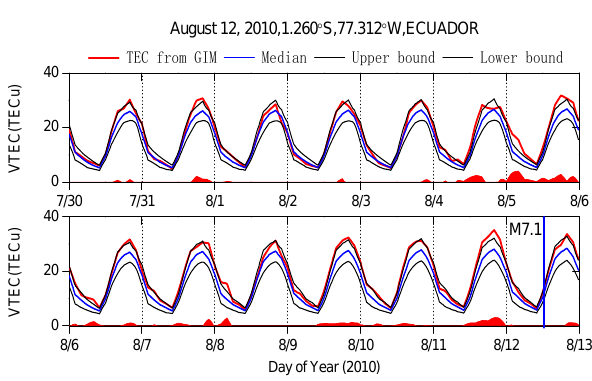
Fig. 10. VTEC time series above the Ecuador epicenter during 30 July 2010 to 12 August 2010. Symbols in this figure are the same as those in Fig.